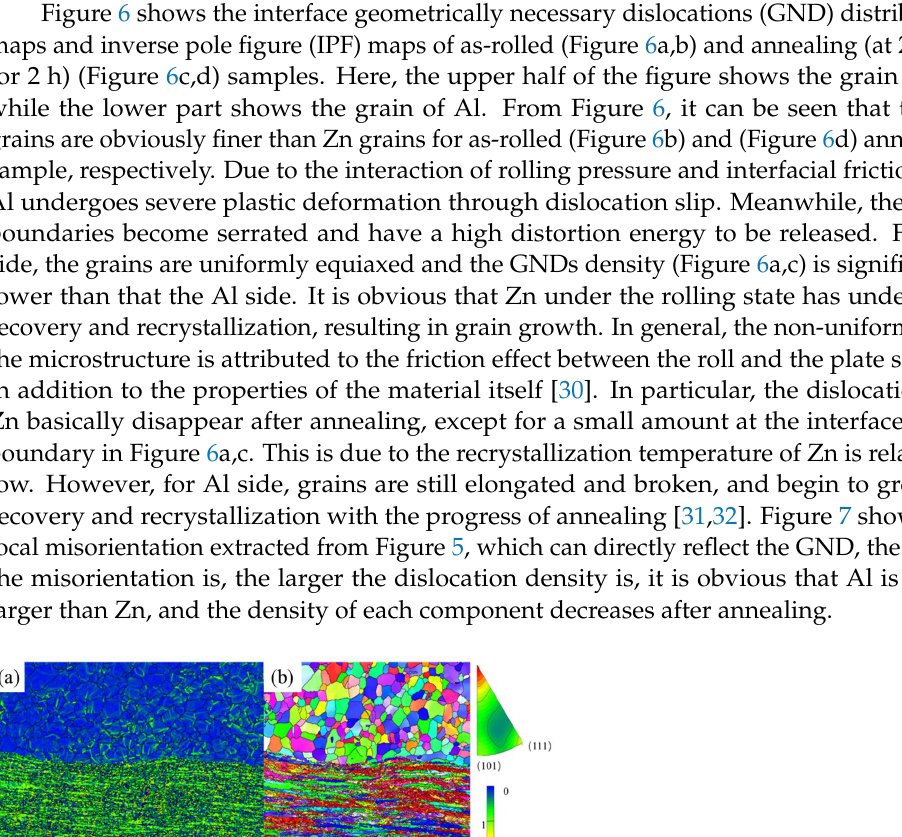
Figure 5. Energy spectrum analysis under different annealing conditions, Figure ( a – d ) shows line scanning, ( a ) rolled state; ( b ) 240 °C for 1.5 h; ( c ) 280 °C for 1.5 h; ( d ) 320 °C for 2 h, and Panel ( e ) shows point scanning at 320 °C for 2 h. ( a ) rolled state; ( b ) 240 ◦ C for 1.5 h; ( c ) 280 ◦ C for 1.5 h; ( d ) 320 ◦ C for 2 h, and Panel ( e ) shows point scanning at 320 ◦ C for 2 h.